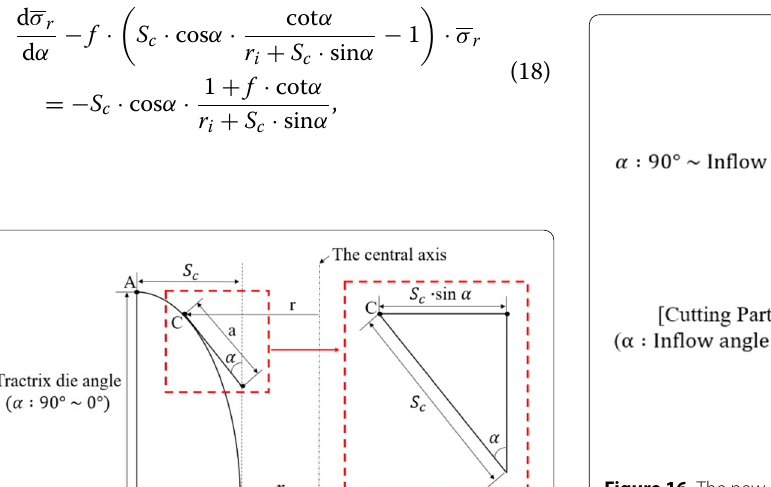
Figure 16 The new design to calculate tractrix